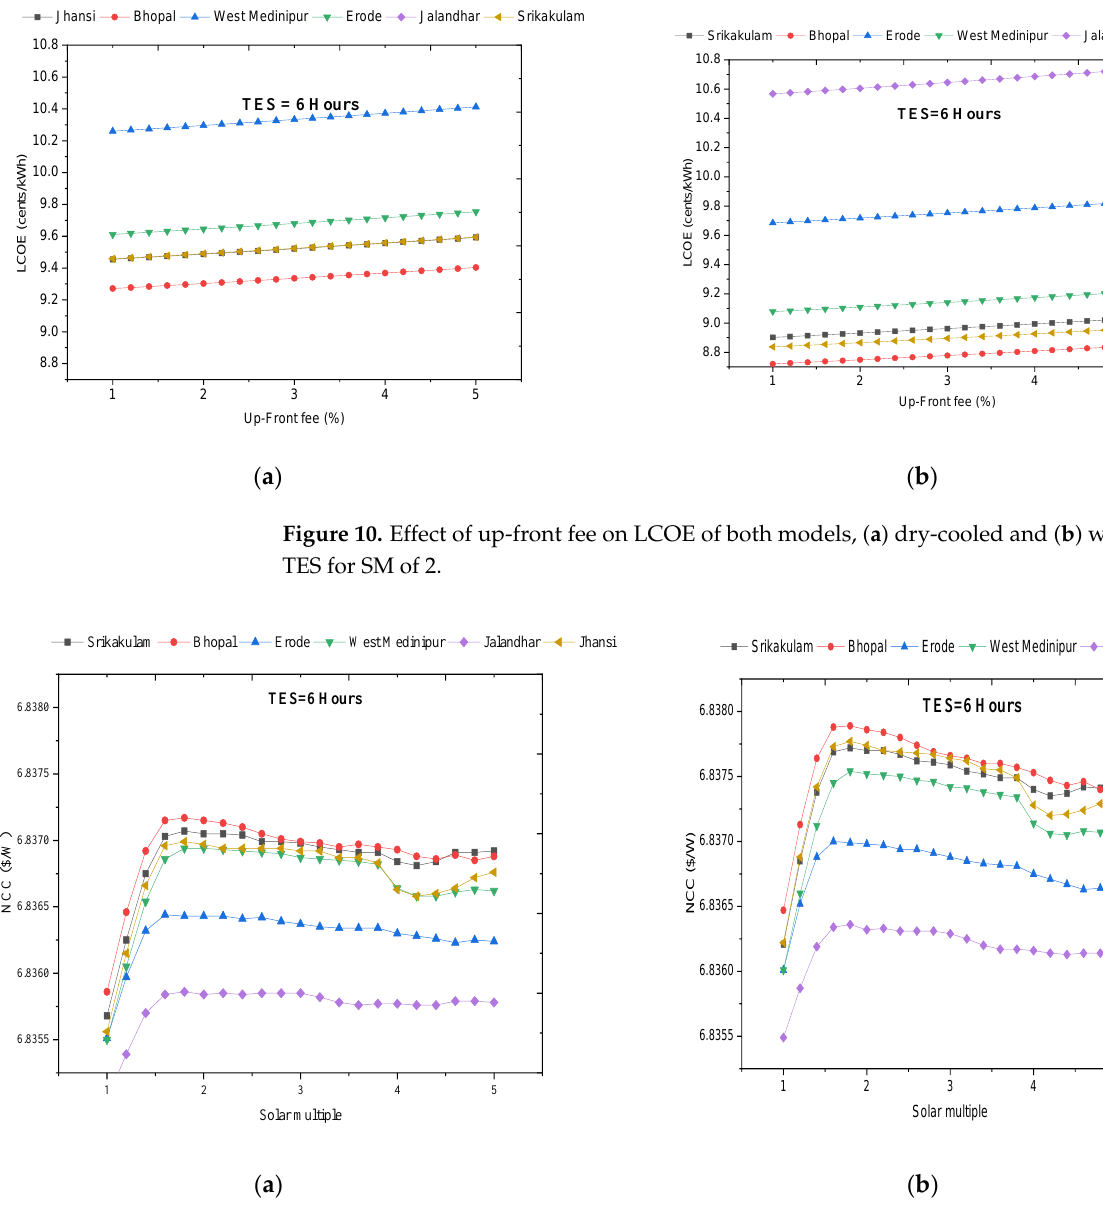
Figure 9. Effect of sales tax rate on the LCOE of both models, ( a ) dry-cooled and ( b ) wet-cooled, at 6 h TES for SM of 2.